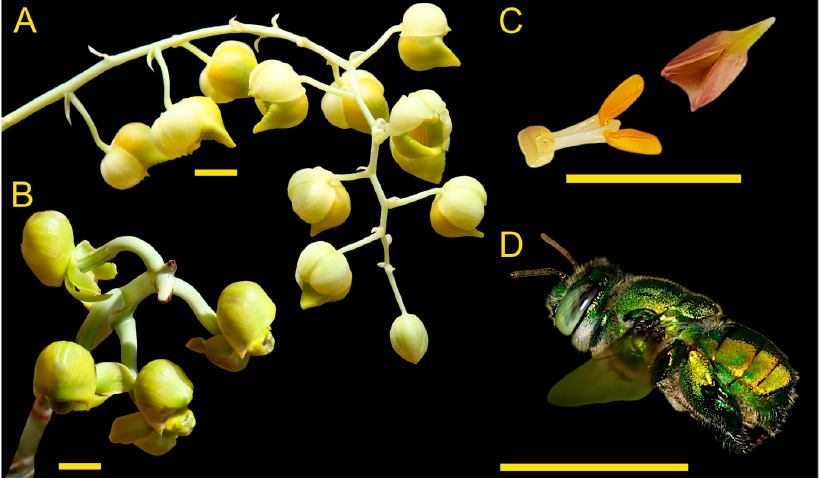
Figure 1. Overview of the C. maranhense pollination system: ( A ) male inflorescence, ( B ) female inflorescence, ( C ) pollinarium with two pollinia, and ( D ) male E. securigera bee. Yellow scale bars: 1 cm. Photos ( A , B ) by JBFS, ( C ) by KB, and ( D ) by PMP.